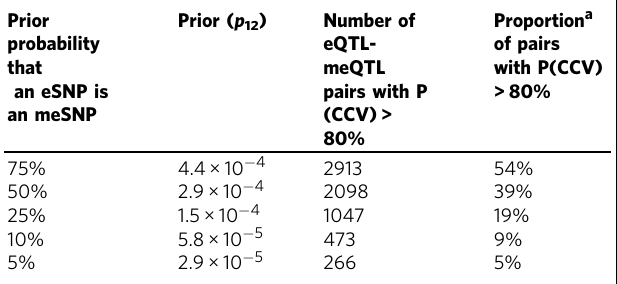
Table 2 Number of eQTL-meQTL pairs with probability of a common causal variant (P(CCV)) > 80%, indicating likely “ co-localization ” , for various values of the prior p